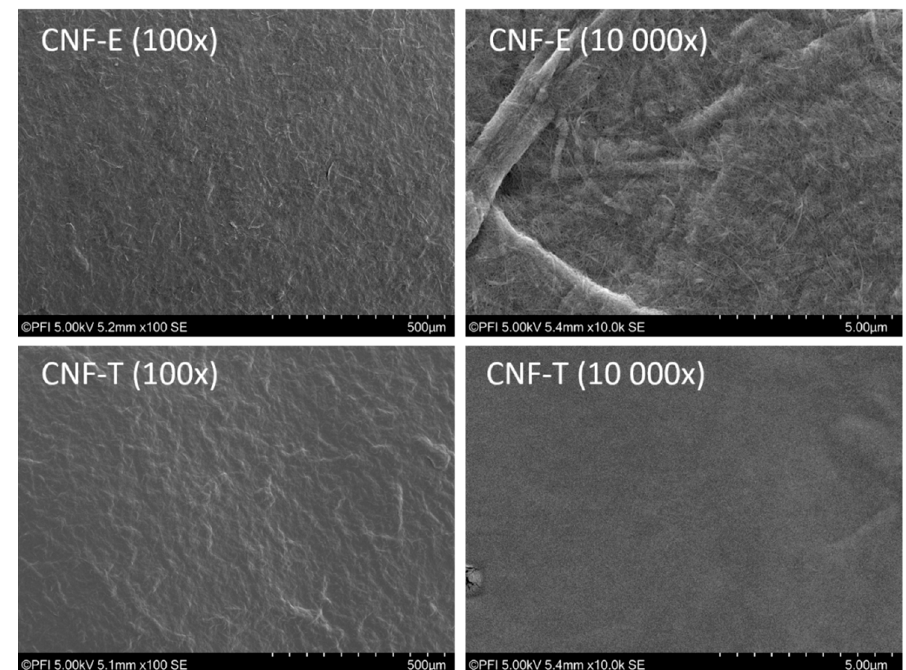
Figure 1. Scanning electron microscopy (SEM) images of the top surface of air-dried CNF films recorded at 100 × and 10,000 × magnification of enzymatically treated CNFs (upper) and TEMPO-oxidized CNFs (lower).